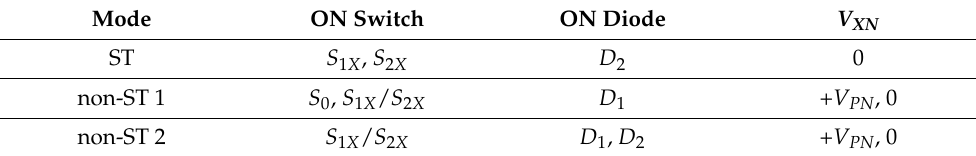
Table 1. On/Off states of ADC-qZSI ( X = A , B , C ). Mode ON Switch ON Diode V XN